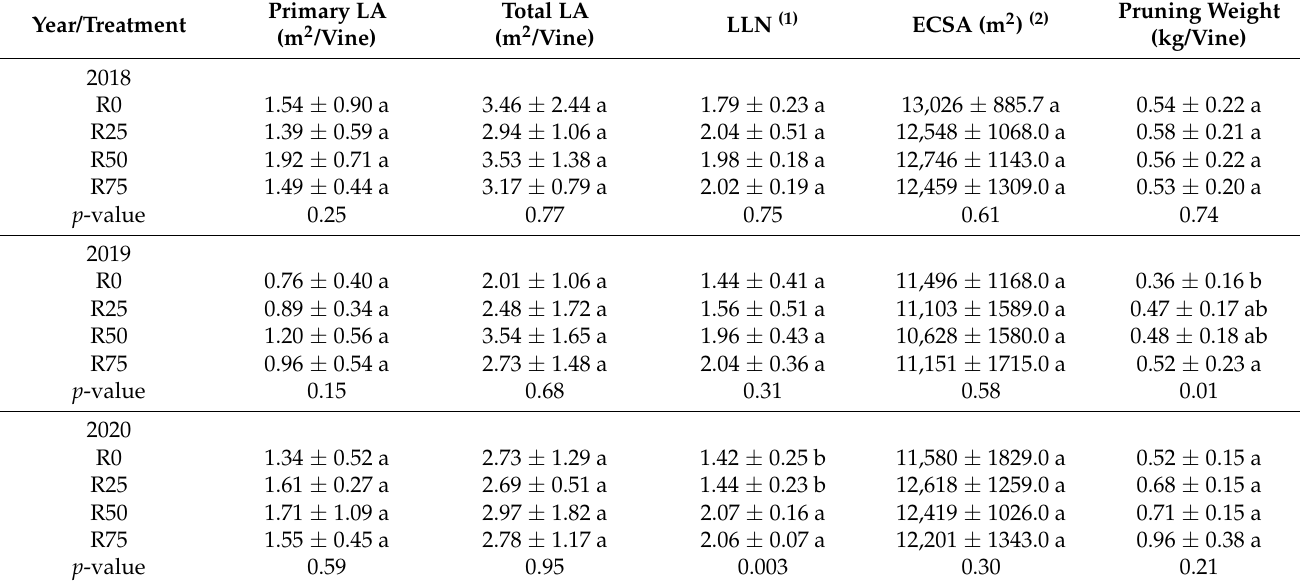
Table 1. Primary leaf area, total leaf area, leaf layer number (LLN), exposed canopy surface area (ECSA), and pruning weight of rainfed and irrigated vines during each season. Values are represented as mean ± standard deviation. In each column, values with different letters show a statistical significance at p < 0.05 by Tukey HSD test. ( 1 ) Assessed by point quadrat methodology [27]. ( 2 ) Assessed by exposed canopy surface area